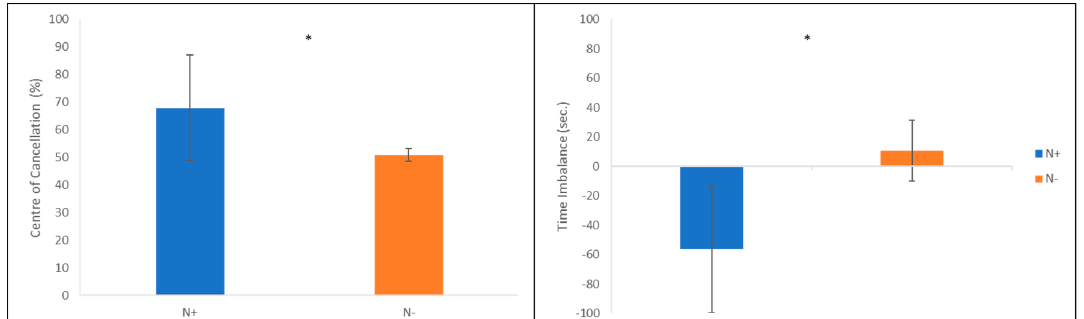
Figure 5. On the left, time imbalance mean scores of N+ and N − patients (seconds; positive values represent time spent on the left, while negative values represent time spent on the right); On the right, CoC mean scores of N+ and N − patients (percentages; values higher than 50 represent a CoC shifted toward the right, while values lower than 50 represent a CoC shifted toward the left). Error bars represent ± 1 DS. Asterisk represents a signi fi cant di ff erence. Table 3. Means ± standard deviations of the performances of healthy participants and patients at the new parameters of the computerized tests (time of imbalance and CoC).